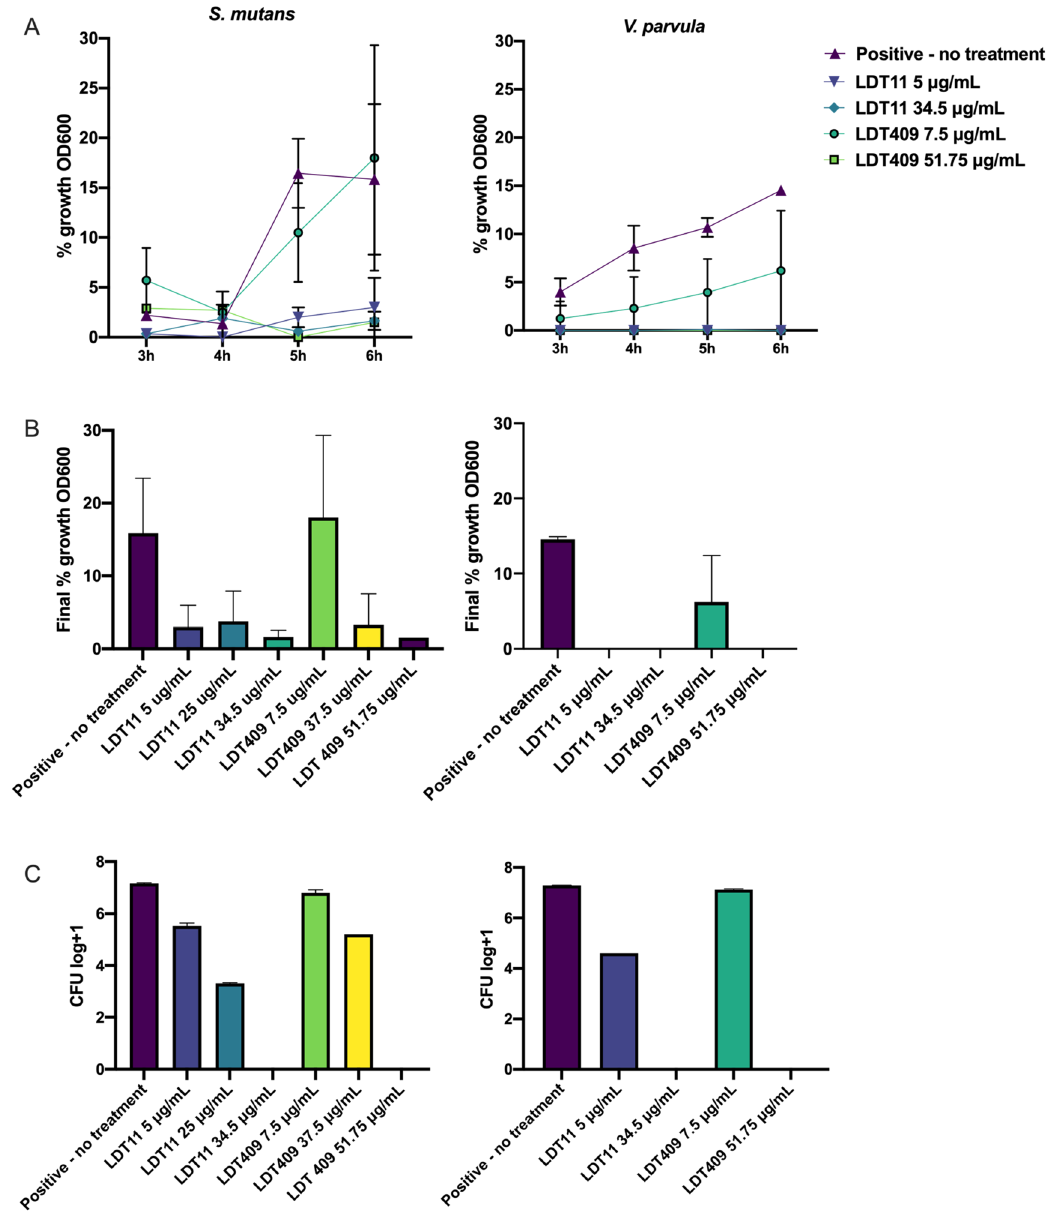
Figure 2. Proportion of planktonic bacterial growth. Streptococcus mutans R9 and Veillonella parvula ATCC17745 were treated with various concentrations of CNSL-derivatives LDT11 (anacardic acid-derivative) and LDT409 (cardanol-derivative) (OD600). ( A ) Growth curve (% of OD600 growth compared to the baseline immediately after inoculation)—Friedman test, p = 0.003 and 0.002 for S. mutans and V. parvula , respectively; ( B ) Final proportion of growth after 6 h—Kruskal–Wallis test, NS and p = 0.01, for S. mutans and V. parvula , respectively; C-CFU (in log + 1) after 6 h of incubation – Kruskal–Wallis test, < 0.0001 and p = 0.003, for S. mutans and V. parvula ,